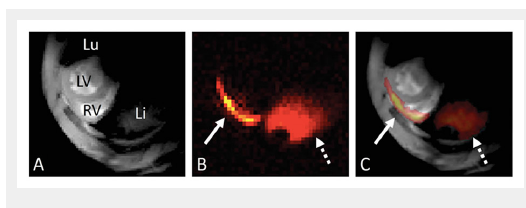
Fluorine-19 magnetic resonance imaging of myocarditis. (A) 1 H magnetic resonance imaging (MRI) slice in the short-axis orientation at the base of the heart in the experimental autoimmune myocarditis mouse model; 1 H-MRI depicts the right and left ventricles (RV and LV) as well as the lung (Lu) and liver (Li). (B) 19 F-MRI of the same anatomical location. Two regions with a 19 F signal can be observed: a thin line at the level of the myocardium (whole arrow) and a larger region at the level of the liver (dotted arrow). (C) Fusion of the 1 H and thresholded 19 F images: the 19 F signal collocalises with the RV free wall and the liver (reproduced from